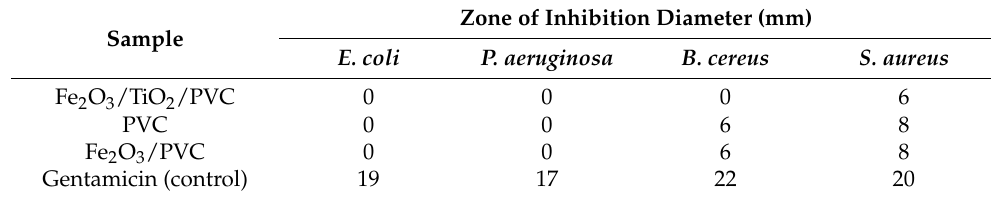
Table 3. Antibacterial activity of photocatalysts determined by agar diffusion method.